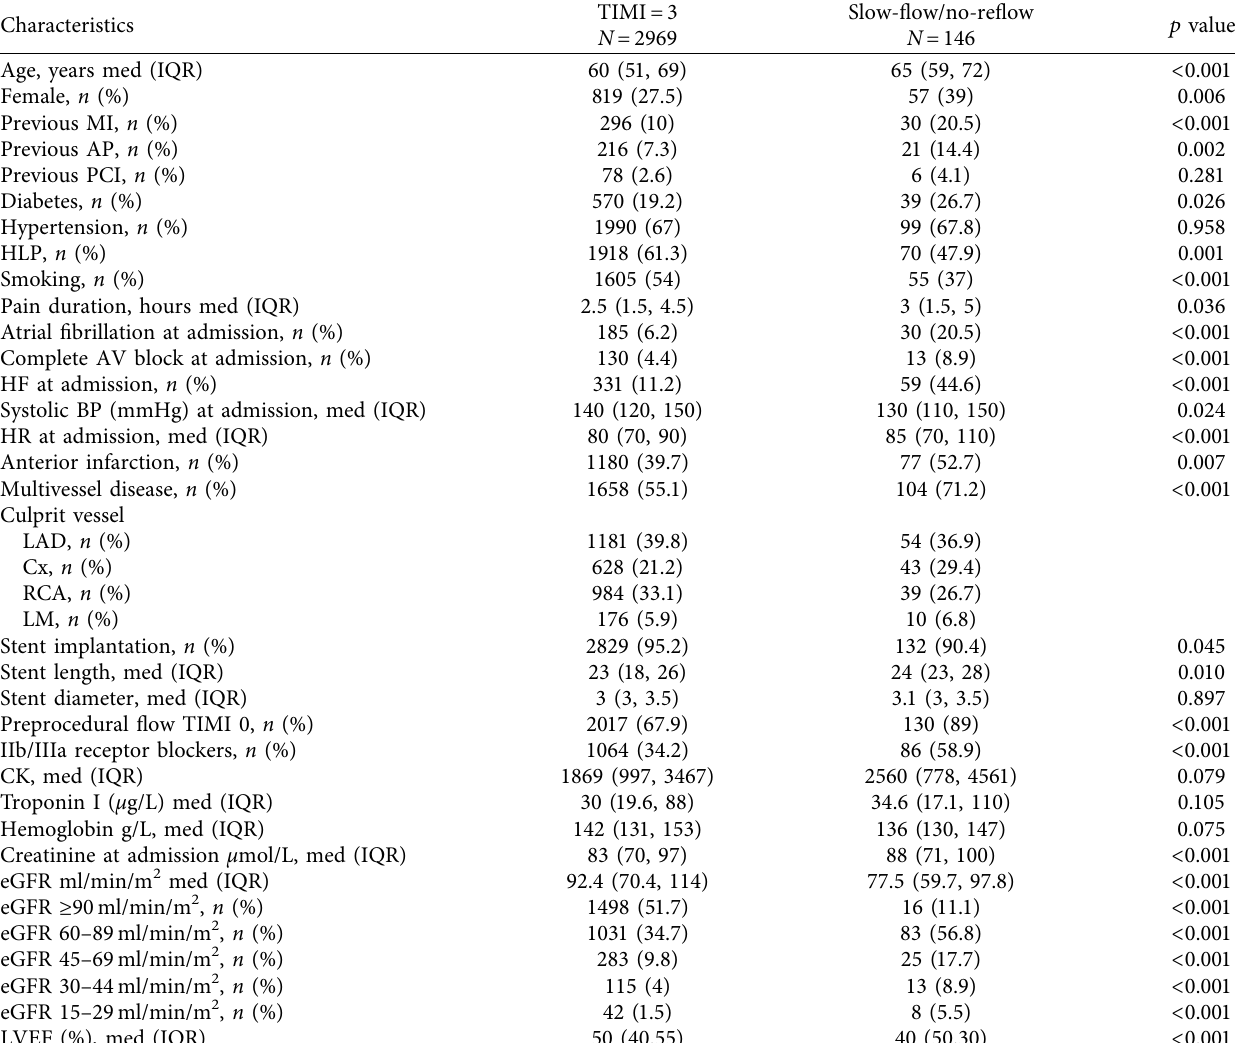
Table 1: Baseline characteristics, kidney function, and in-hospital mortality according to the postprocedural TIMI fow grade.